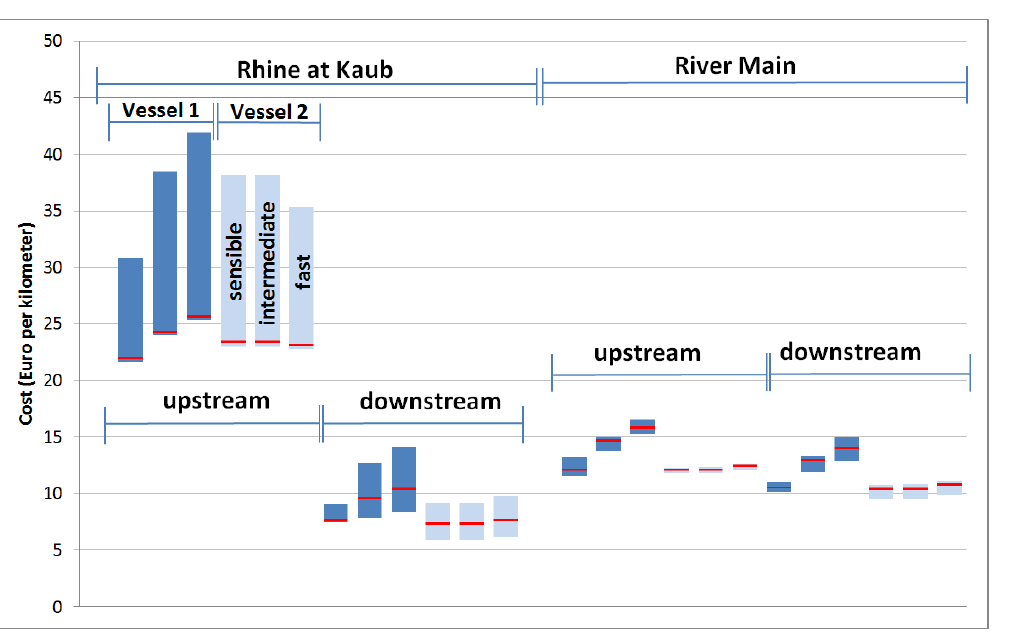
Figure 13. Cost analysis for selected waterway